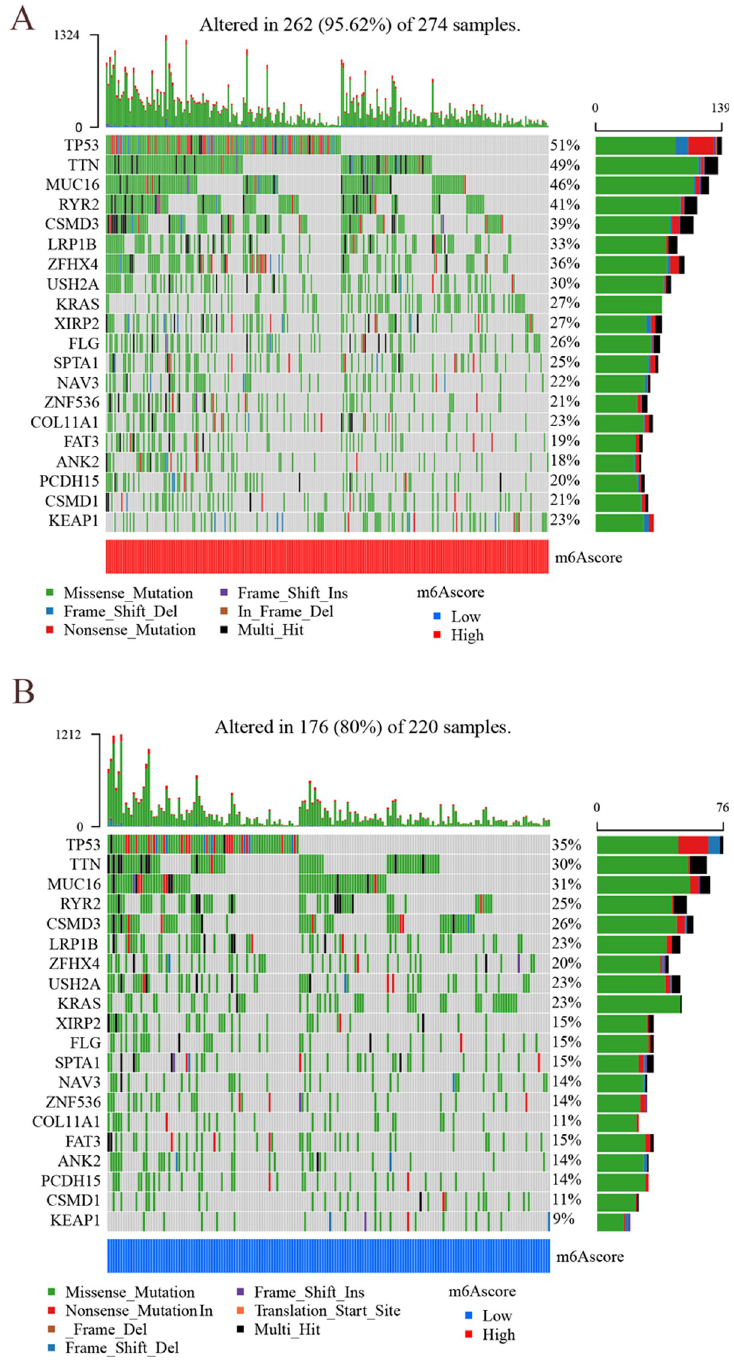
Fig 13. Mutation waterfall plot for high and low m 6 A score groups. (A) The mutation rates of high m 6 A score groups. The left vertical coordinate indicates m 6 A-related modified genes, and the right vertical coordinate indicates gene mutation rate in LUAD. (B) The mutation rates of low m 6 A score groups. The left vertical coordinate indicates m 6 A-related modified genes, and the right vertical coordinate indicates gene mutation rate in LUAD.